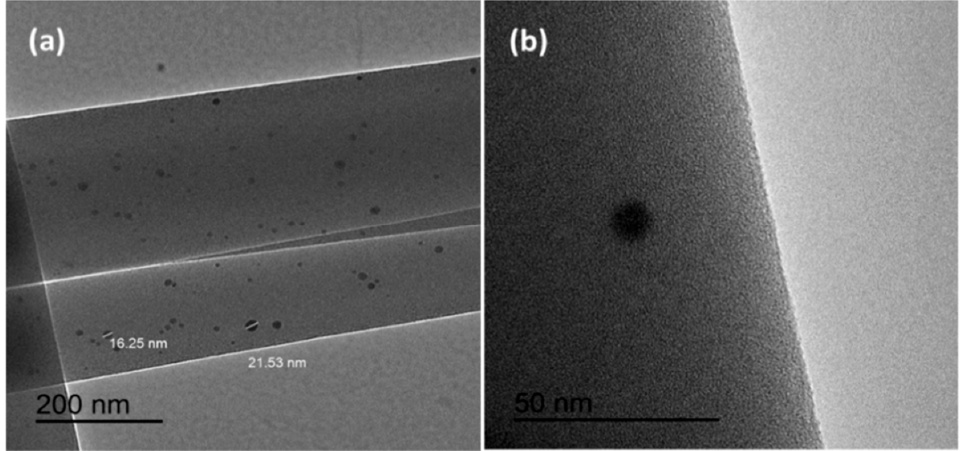
Figure 3. TEM micrographs of electrospun fibers: ( a , b ) PVP/CNC-4%/AgNO 3 -0.34%.